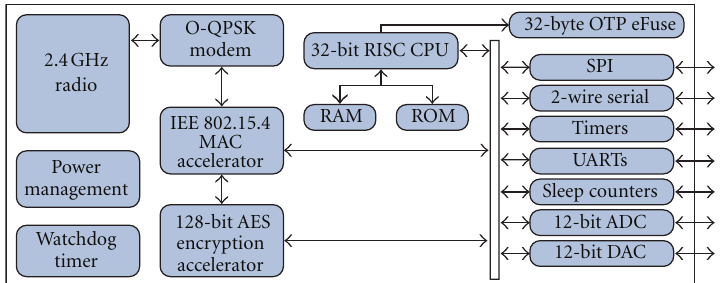
Figure 12: SoC architecture for wireless sensor networks in energy